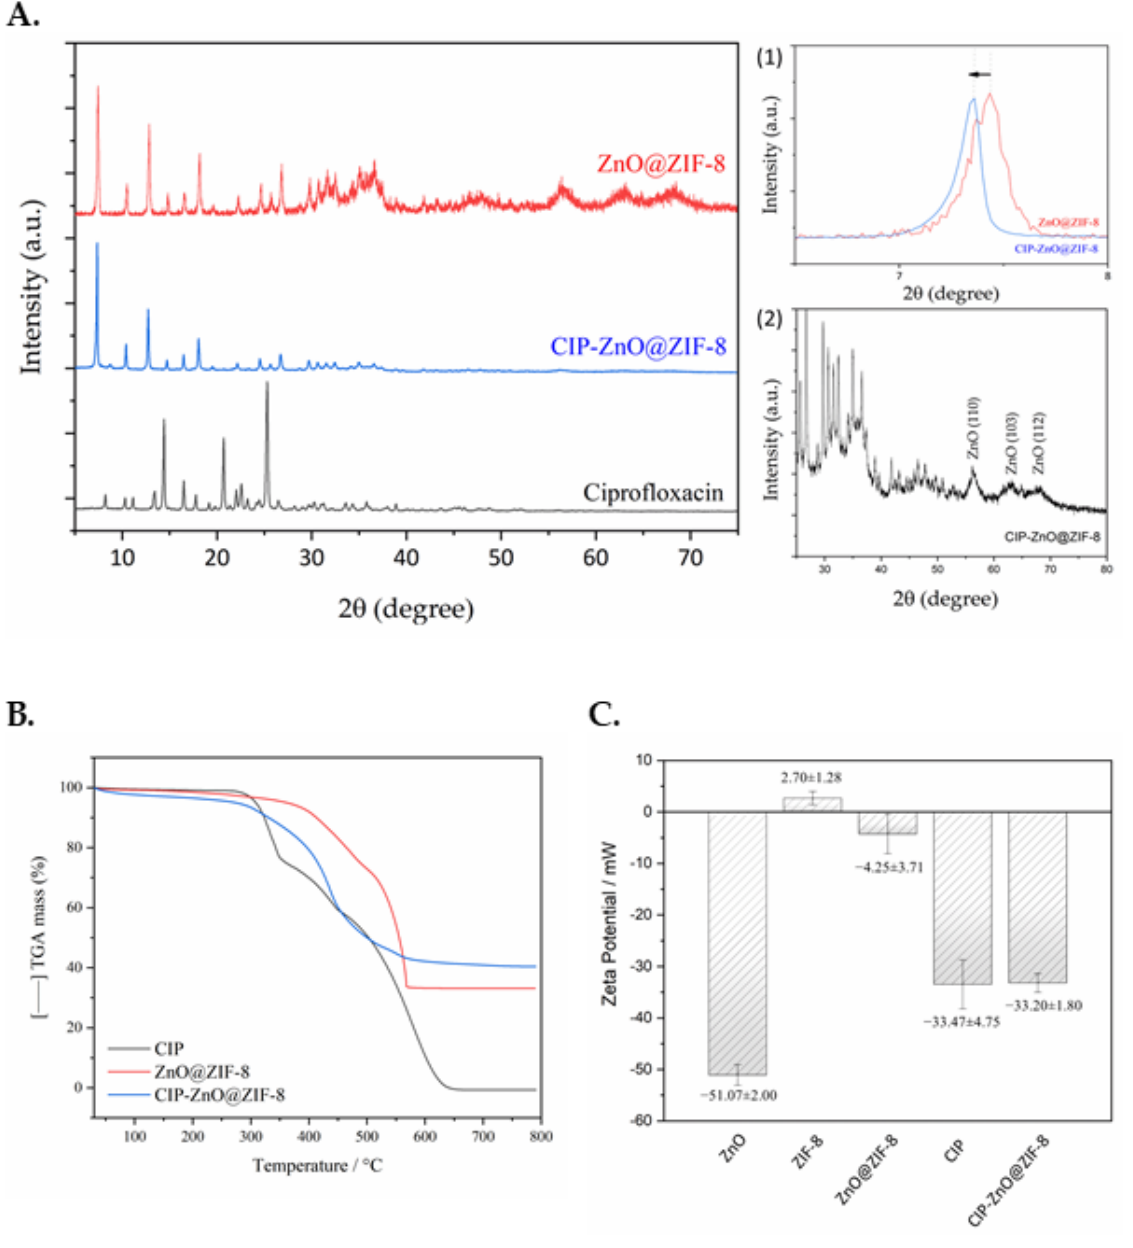
Figure 4. XRD analysis of CIP-ZnO@ZIF-8 after incorporation assays ( A ), with shift peak identification ( A1 ) and identification of ZnO after incorporation ( A2 ); TGA analyses of CIP, ZnO@ZIF-8, and CIP-ZnO@ZIF-8 ( B ); Zeta potential measurements for ZnO, ZIF-8, ZnO@ZIF-8, CIP, and CIP-ZnO@ZIF-8 NPs (n = 3) ( C ).